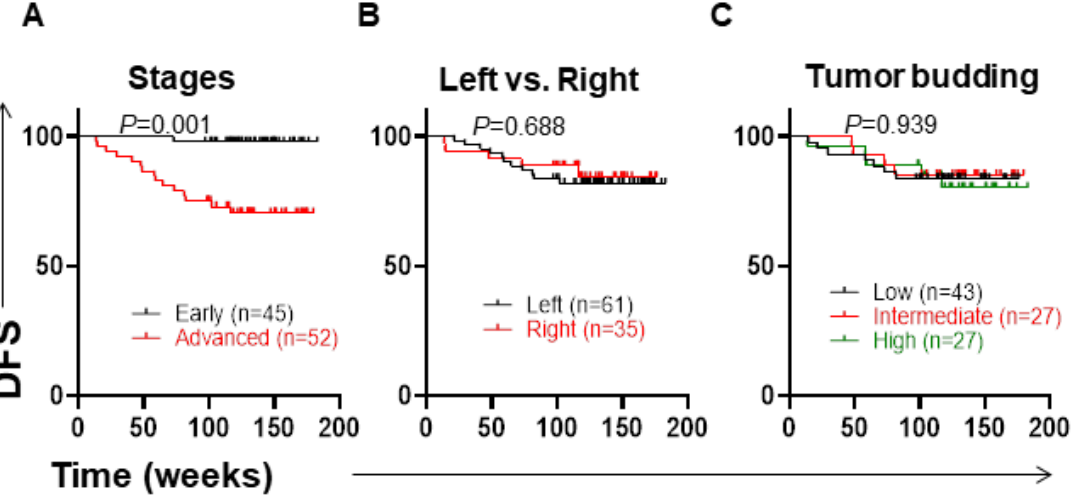
Figure 3. Kaplan–Meier curves of disease-free survival (DFS) based on TNM stages, anatomical location, and tumor budding. Patients were divided into groups based on stages (early and advanced) ( A ), anatomical location (left and right) ( B ), and tumor budding (low, intermediate, high) ( C ), and DFS was determined for these groups.